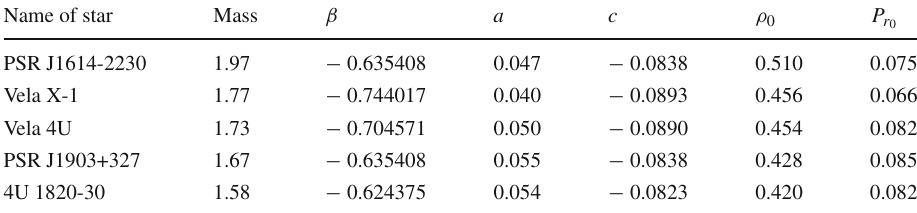
Table 1 Mass ( m ) , central density (ρ) and central radius P r of different stars 0 corresponding to α = 1 . 95 and b = − 10 .